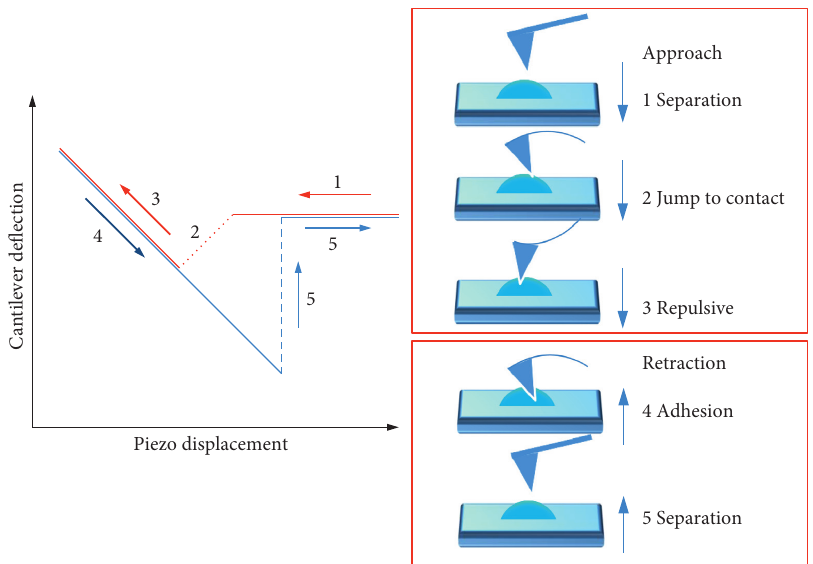
Figure 5: AFM force-displacement curves (left) and the related cantilever